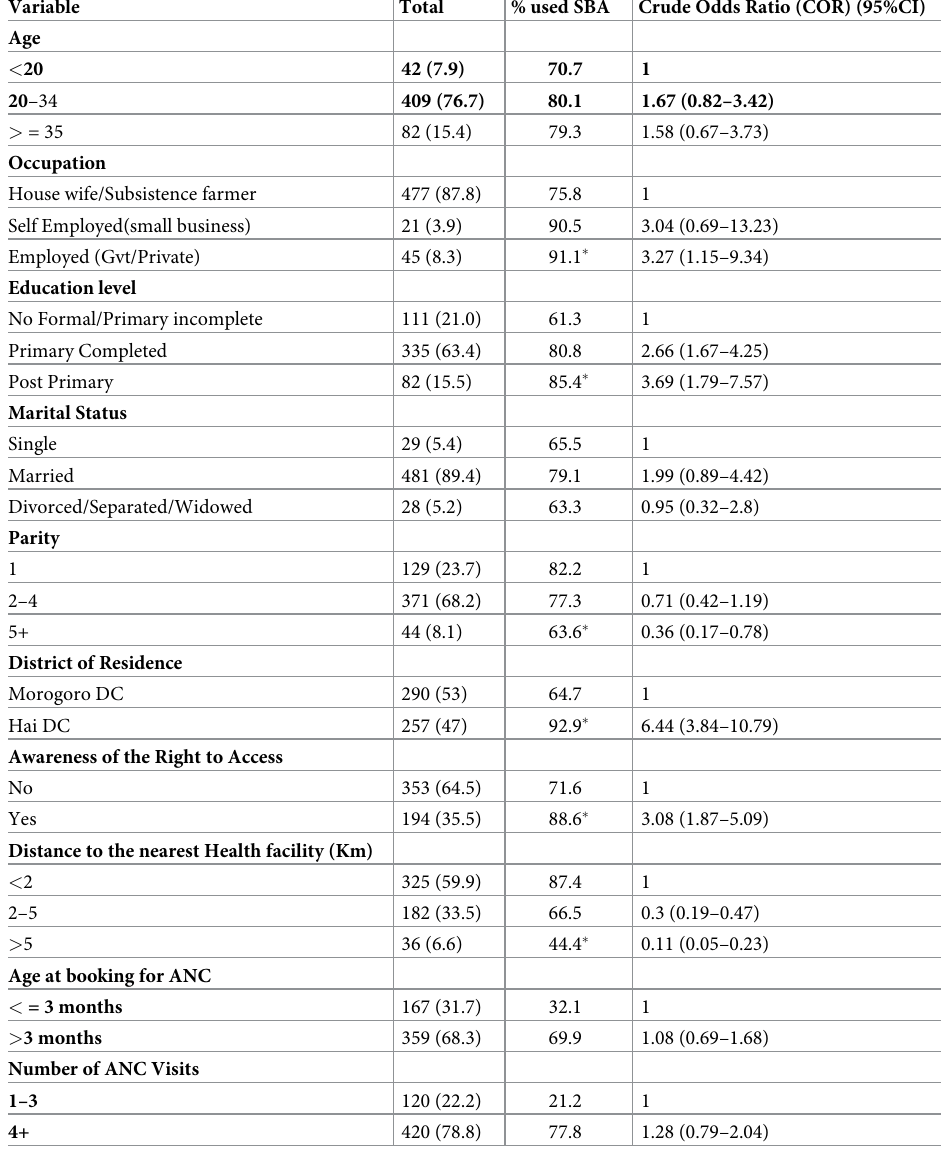
Table 4. Utilization of SBA and associated factors analysed using binary logistic